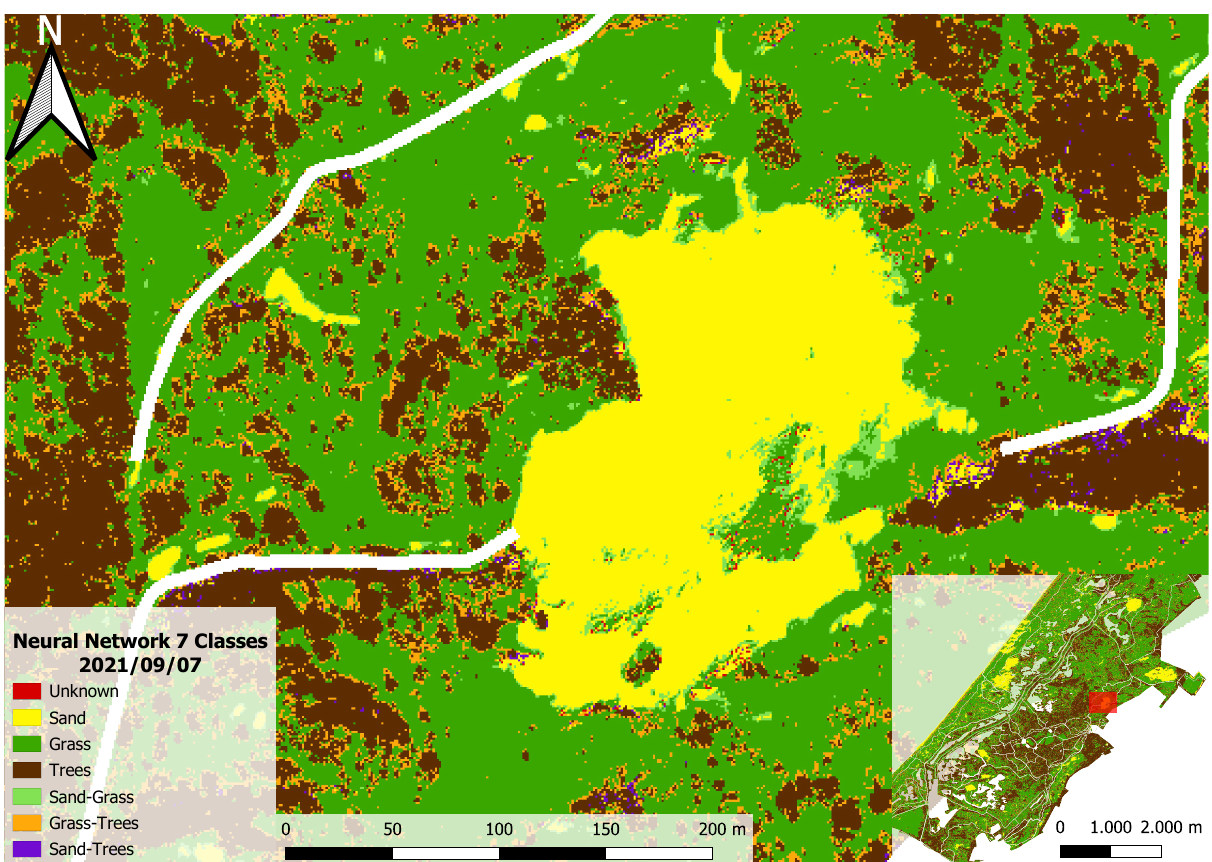
Figure 5. Map showing location of pure and fuzzy class pixels, as obtained by the Neural Network classification. The fuzzy sub-classes are indeed located on the expected transition zones.